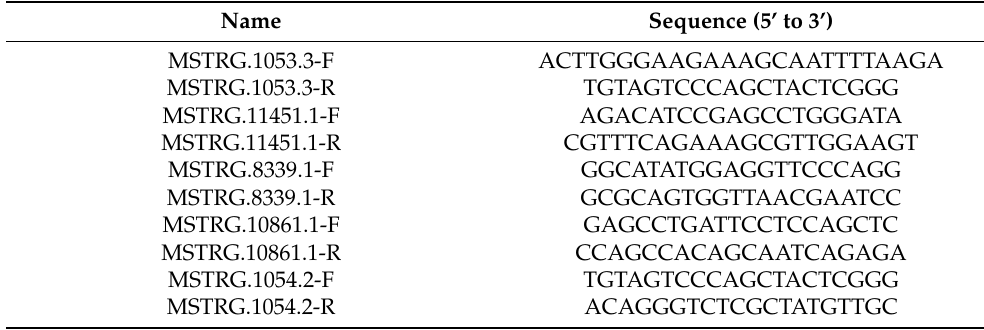
Table 1. Forward and reverse primers used for gene quantification by RT-qPCR.